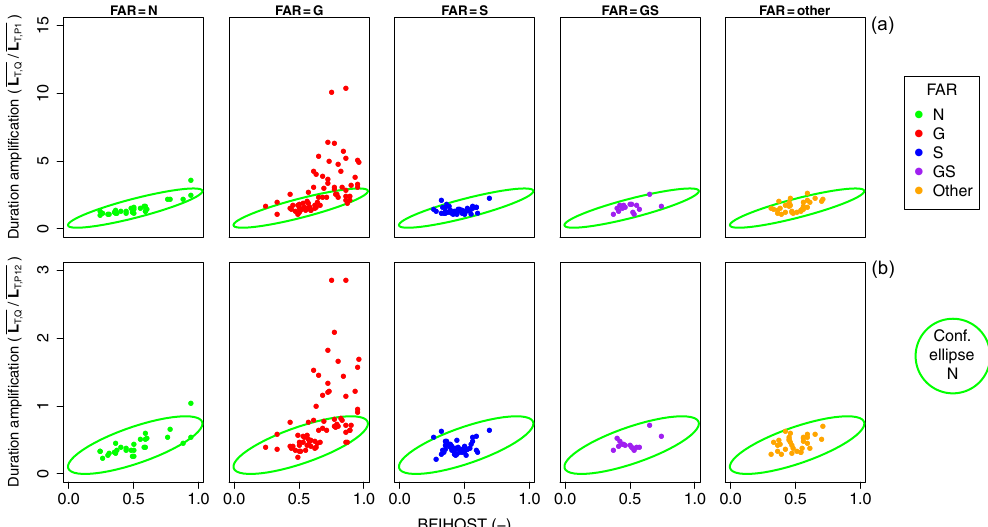
Figure 5. Amplification of average monthly streamflow drought duration over average monthly precipitation drought duration ( L T,Q /L T,P , a , and L T,Q /L T,P , b ) versus BFIHOST for catchments labelled with different FAR codes (colours). Ellipse reflects the 1 12 95% confidence ellipse for catchments with near-natural flow records (FAR =